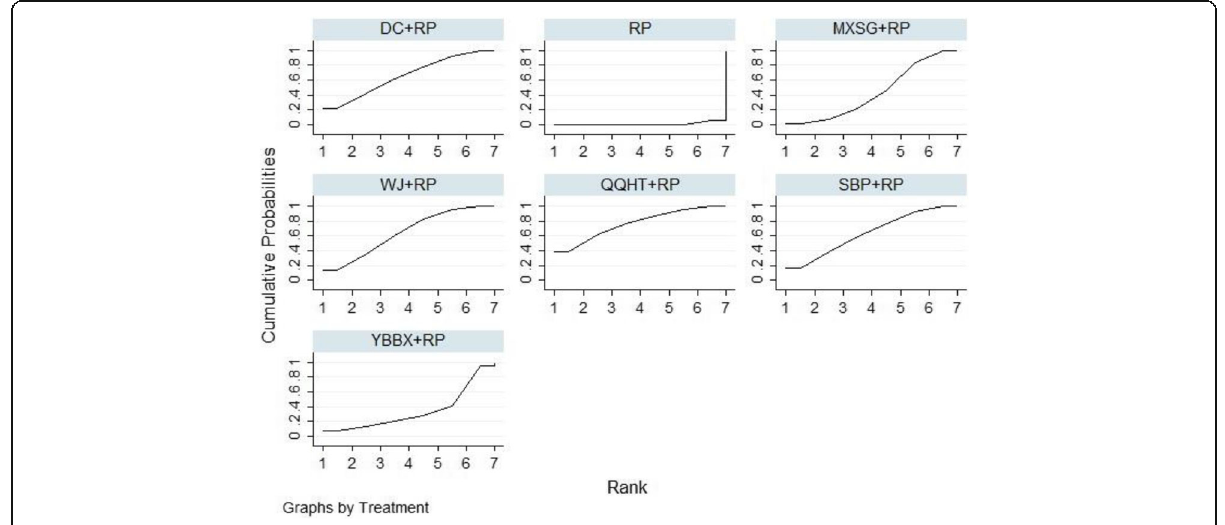
Fig. 7 SUCRA for effective